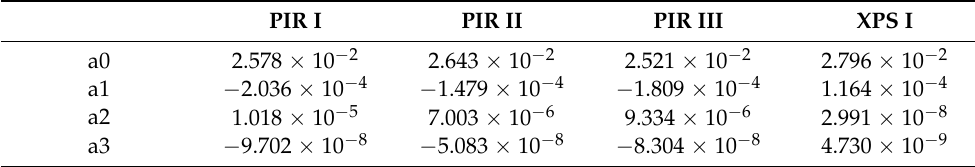
Table 4. Cubic polynomial coefficients for closed-cell foam insulation aged at 23 ◦